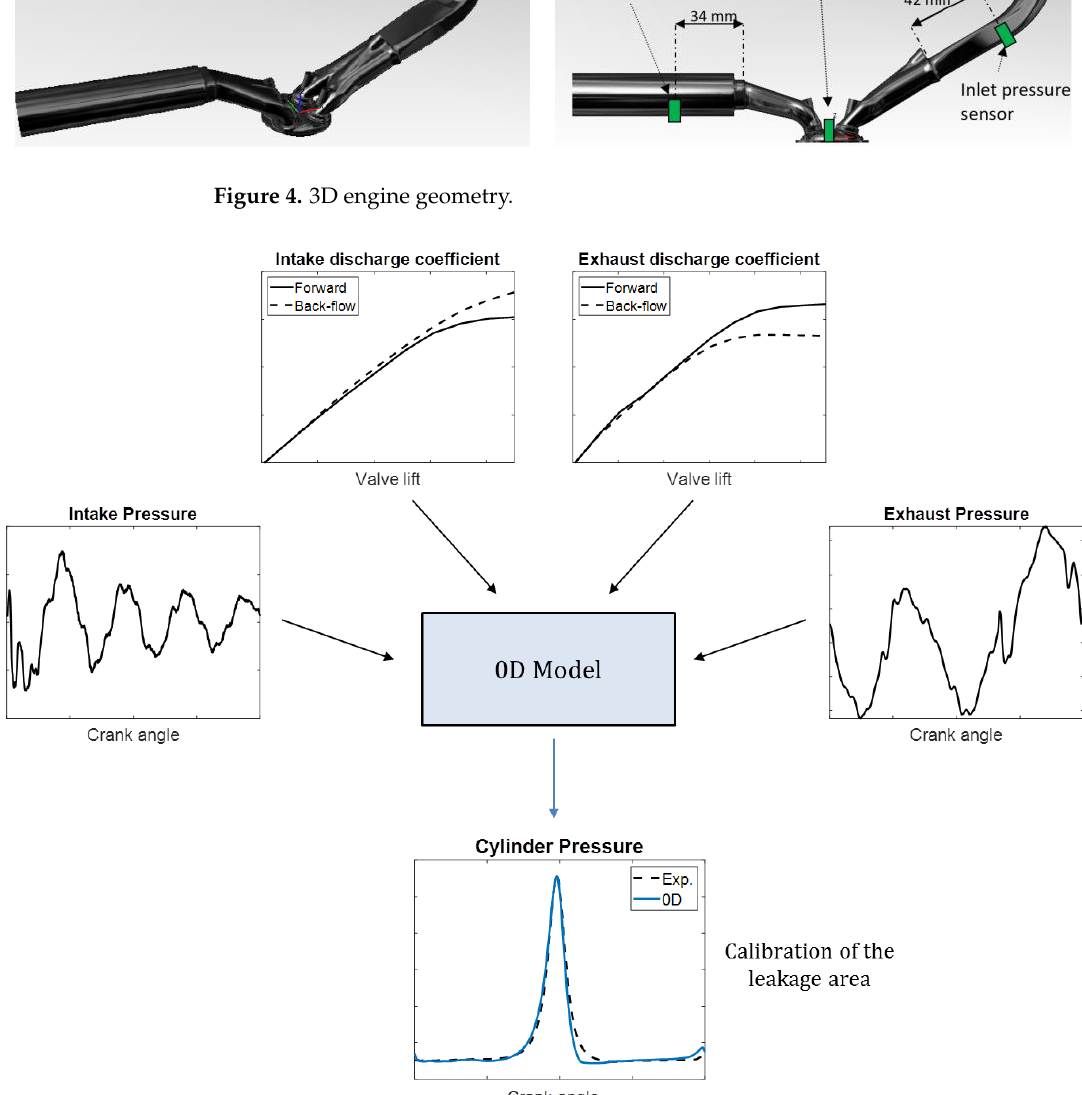
Figure 5. 0D modeling of the transparent engine — blow-by rate estimation.